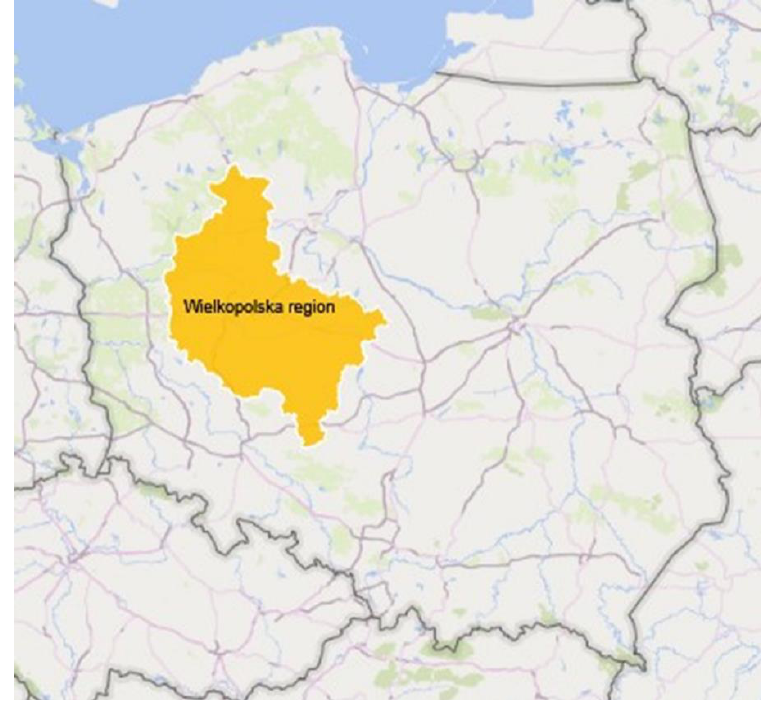
Figure 1. Location of the study region in Poland. Table 1. Utilized agricultural area (UAA) and location of the studied farms with wheat production in conventional tillage (CT), reduced tillage (RT), and no-tillage (NT)